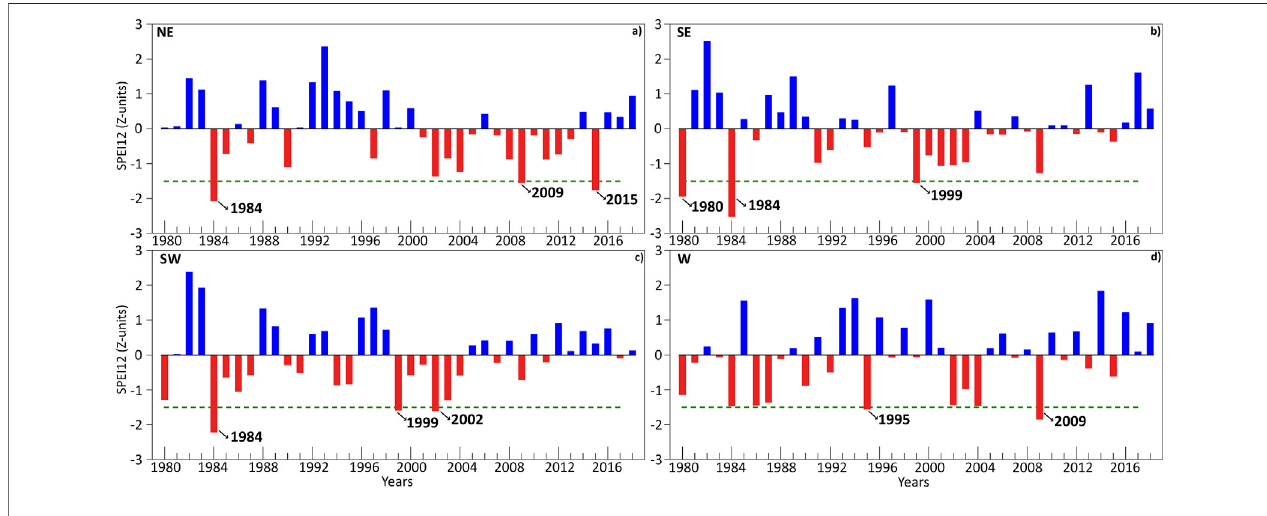
FIGURE8| Annualstandardisedprecipitationevapotranspirationindex(December - SPEI12)fortheNE (A) ,SE (B) ,SW (C) ,andW (D) groups.Period:1980 – 2018. The green dashed line indicates years where SPEI12 values were lower than − 1.50 (severely dry conditions).